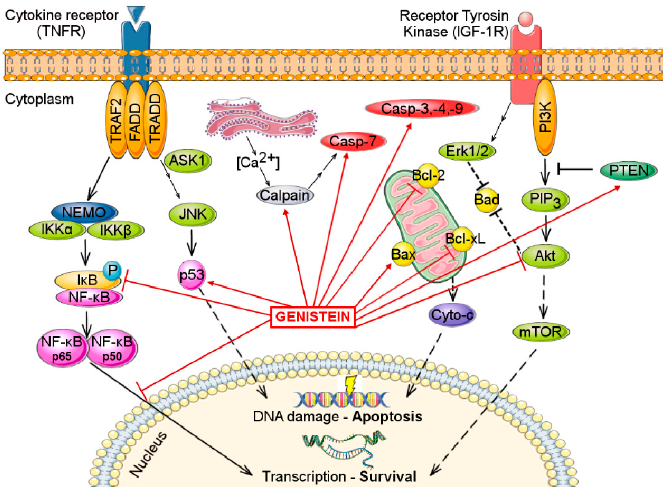
Figure 3. The main molecular targets of genistein that are involved in apoptosis and cell survival mechanisms. Arrow-headed lines indicate activation (or upregulation) and bar-headed lines indicate inhibition (or downregulation). Abbreviations: Akt, Protein kinase-B; ASK1, Apoptosis signal-regulating kinase 1; Bad, Bcl-2-associated death promoter; Bcl-2, B-cell lymphoma 2; Bcl-xL, B-cell lymphoma-extra large; Casp-3,-4,-9, Caspases 3, 4 and 9; Cyto-c, Cytochrome-c; Erk1/2, Extracellular-signal-regulated kinase 1/2; FADD, Fas-Associated protein with Death Domain; IKK α and IKK β , I κ B kinases; JNK, Jun amino-terminal kinases; mTOR, mammalian target of rapamycin; NEMO, NF- κ B essential modulator; NF- κ B, Nuclear factor κ B; p53, Tumor protein p53; PI3K, Phosphoinositide 3-kinase; PIP 3 , Phosphatidylinositol (3,4,5)-trisphosphate; PTEN, Phosphatase and tensin homolog; TRADD, TNF receptor-associated death domain; TRAF2, TNF receptor-associated factor